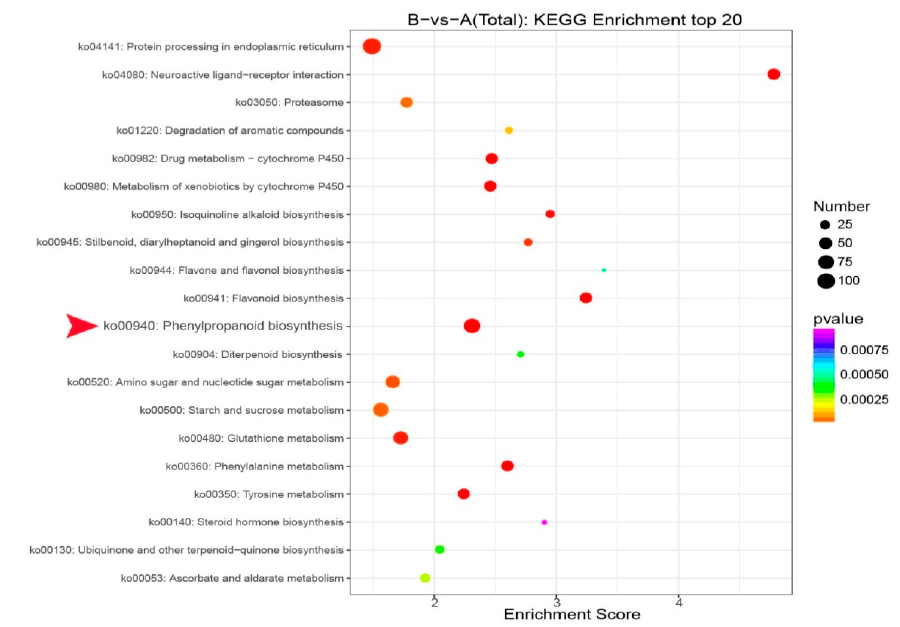
Figure 7. Bubble chart of KEGG enrichment. The x -axis represents the enrichment score. The y -axis represents the name of the KEGG metabolic pathway. The dot size indicates the number of DEGs, and the dot color indicates the p -value; the smaller the p -value, the greater the significance. Red arrow indicates the ‘ko00940: Phenylpropanoid biosynthesis’ pathway. Forests 2020 , 11 , x FOR PEER REVIEW